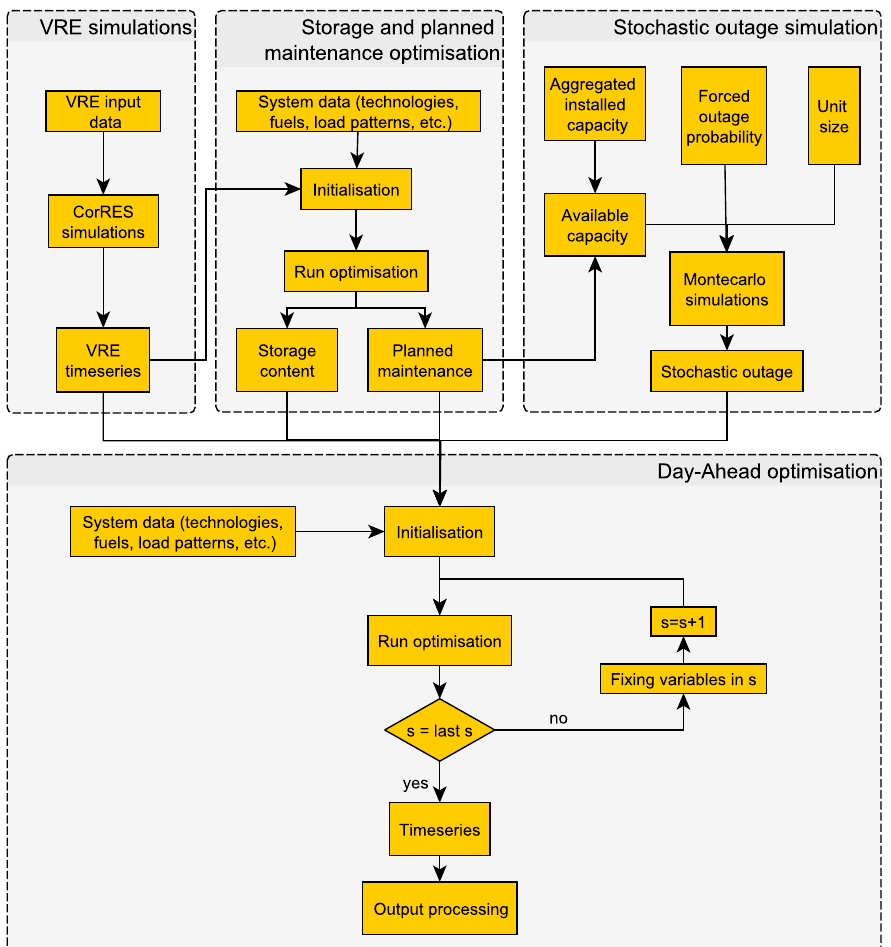
Figure 1. Flow chart of the